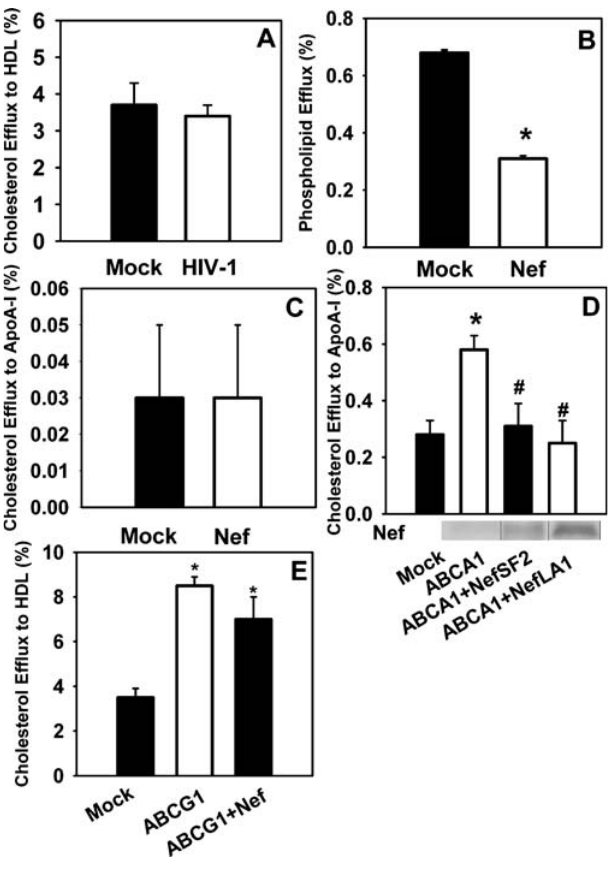
Figure 2. Nef Targets ABCA1-Dependent Cholesterol Efflux (A) Cholesterol efflux to HDL (30 l g/ml) was measured from HIV-1 ADA- infected and mock-infected macrophages used also to measure efflux to apoA-I in Figure 1A. (B) Impairment of phospholipid efflux in Nef-transfected RAW 264.7 cells. RAW 264.7 cells were transfected with plasmid expressing HIV-1 SF2- derived Nef or empty vector (mock-transfection). Phospholipid efflux to apoA-I (30 l g/ml) was measured as described in Methods. Means 6 SD of quadruplicate determinations are shown. An asterisk (*) indicates p , 0.001. (C) Nef does not decrease cholesterol efflux in RAW 264.7 cells not treated with LXR agonist. Experiment was performed using HIV-1 SF2- derived Nef as described in Figure 1C, except that LXR agonist was not added. (D) Cholesterol efflux to apoA-I from HeLa cells. HeLa cells were either mock-transfected (mock) or co-transfected with ABCA1 and empty vector (ABCA1), or vector expressing Nef derived from HIV-1 SF2 (ABCA1 þ NefSF2) or LAI strains (ABCA1 þ NefLAI); cholesterol efflux to apoA-I was analyzed. An asterisk (*) indicates p , 0.001 (versus cells without ABCA1); a number sign (#) indicates p , 0.001 (versus cells without Nef). Expression of Nef determined by Western blot is shown beneath the